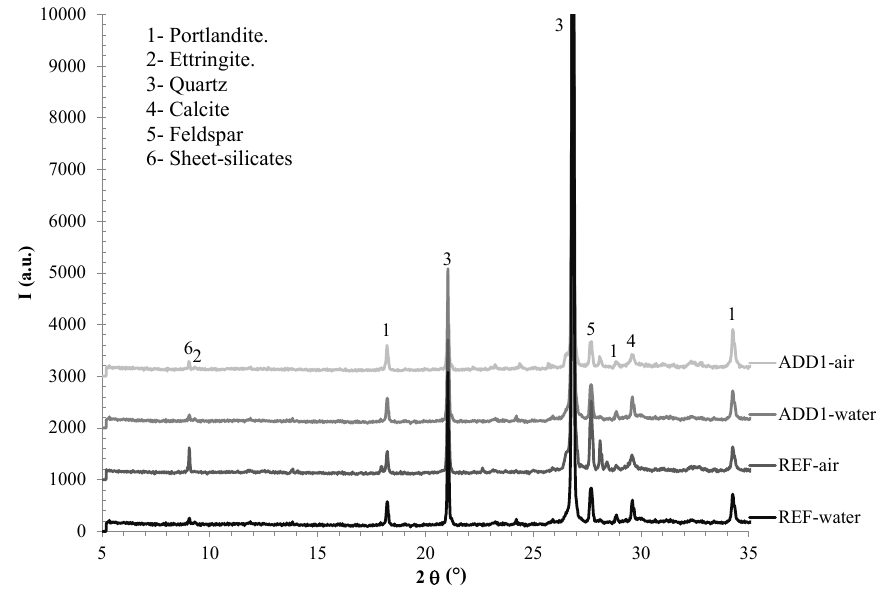
Figure 2. XRD of the concrete samples after 90 days.